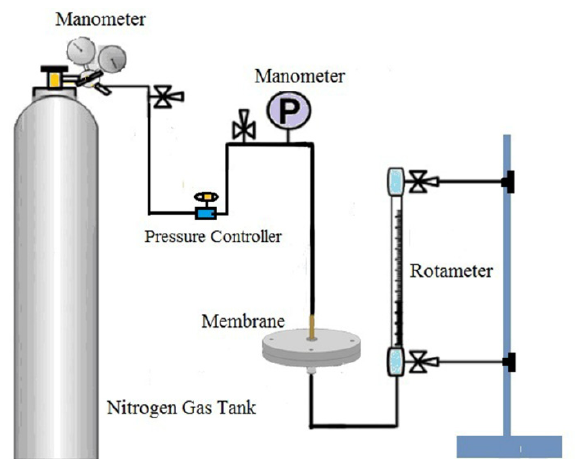
Figure 3. The testing device for the nitrogen flux of dried ultrafine fibrous FEP porous mem-